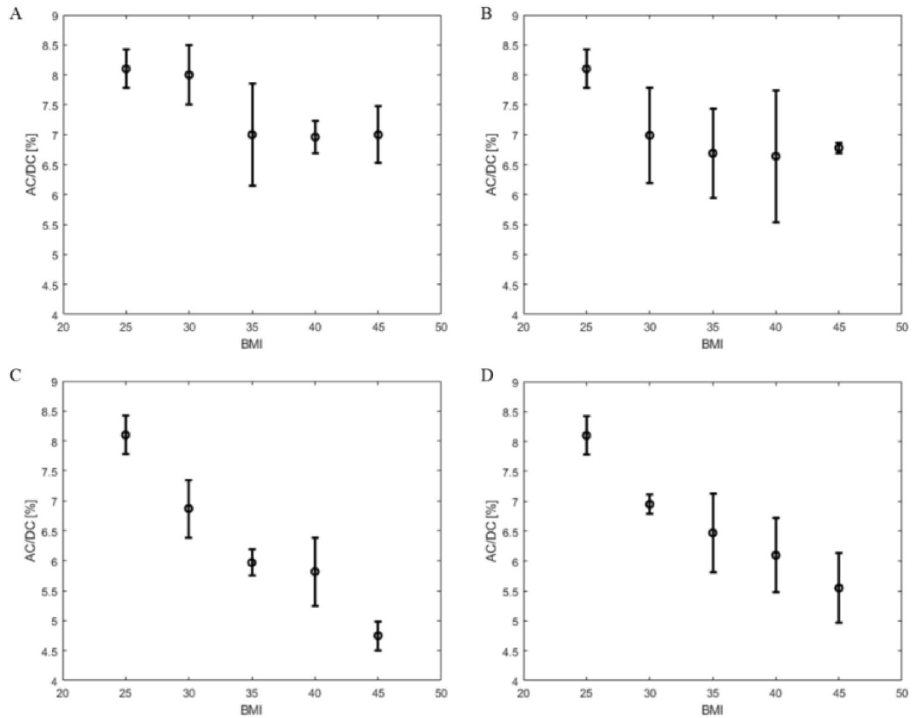
Figure 6. AD/DC PPG signal ratio for changes to trans-epidermal water loss ( A ), dermal blood content ( B ), dermal thickness ( C ), and radial artery depth ( D ) with BMI.